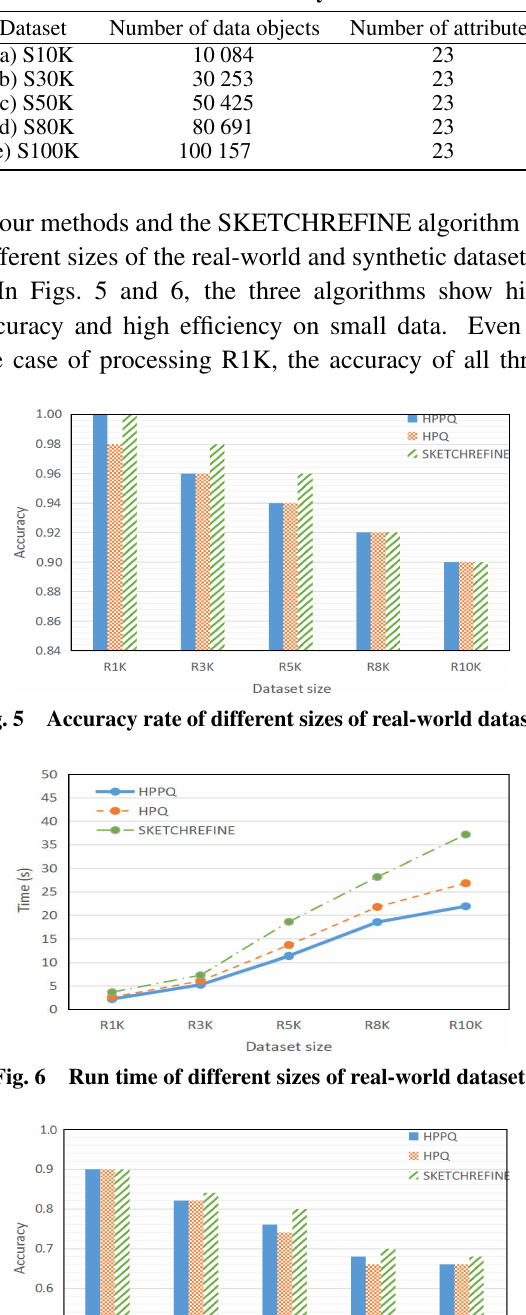
Table 3 Different sizes of synthetic dataset.